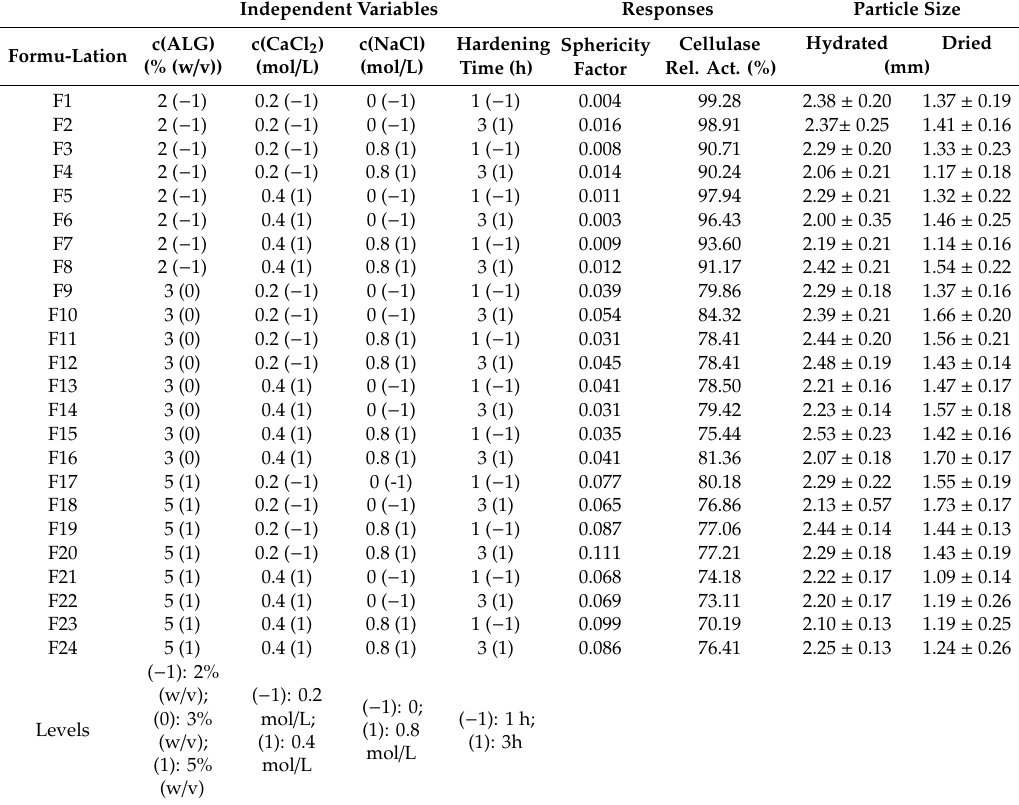
Figure 1. ( a , b ) Optical micrographs of hydrogel alginate beads of: ( a ) formulation F1 (Table 1), scale bar: 3 mm; ( b ) formulation F3 (F1 with addition of 0.8 M NaCl, Table 1), scale bar: 3 mm. ( c – f ) SEM micrographs of the corresponding dried beads: ( c , d ): F1 and F3, respectively, scale bars: 500 µ m; ( e , f ) SEM micrographs at higher magnification showing the surface morphology of F1, scale bars: 2 μ m. Table 1. Matrix of experimental runs for full factorial design to evaluate the relative activity of immobilized cellulase in relation to sphericity, at pH 4.8 and 60 ◦ C, of the hydrated alginate particles from di ff erent formulations obtained by varying the processing parameters. The mean particle sizes of the hydrated and dried alginate beads are also